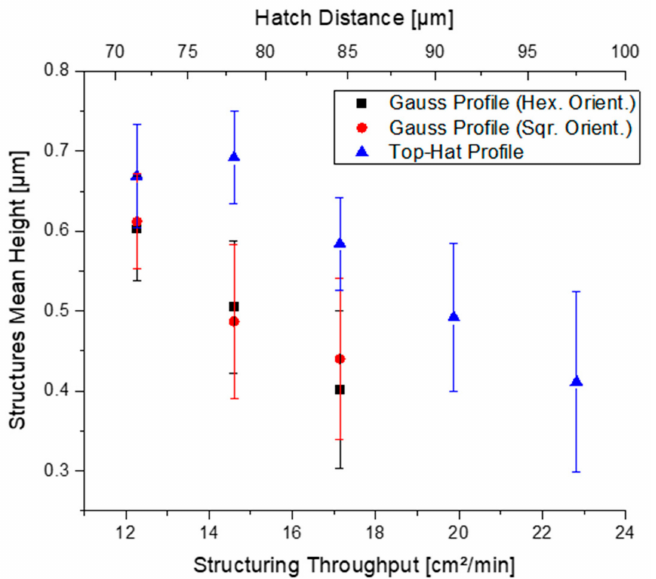
Figure 7. Mean height (S mean ) and standard deviation (S q ) of produced periodic hole-like structures having a filling factor over 80% (produced at F = 2.96 J/cm 2 , with 1.93 W of laser power and a repetition rate of 4